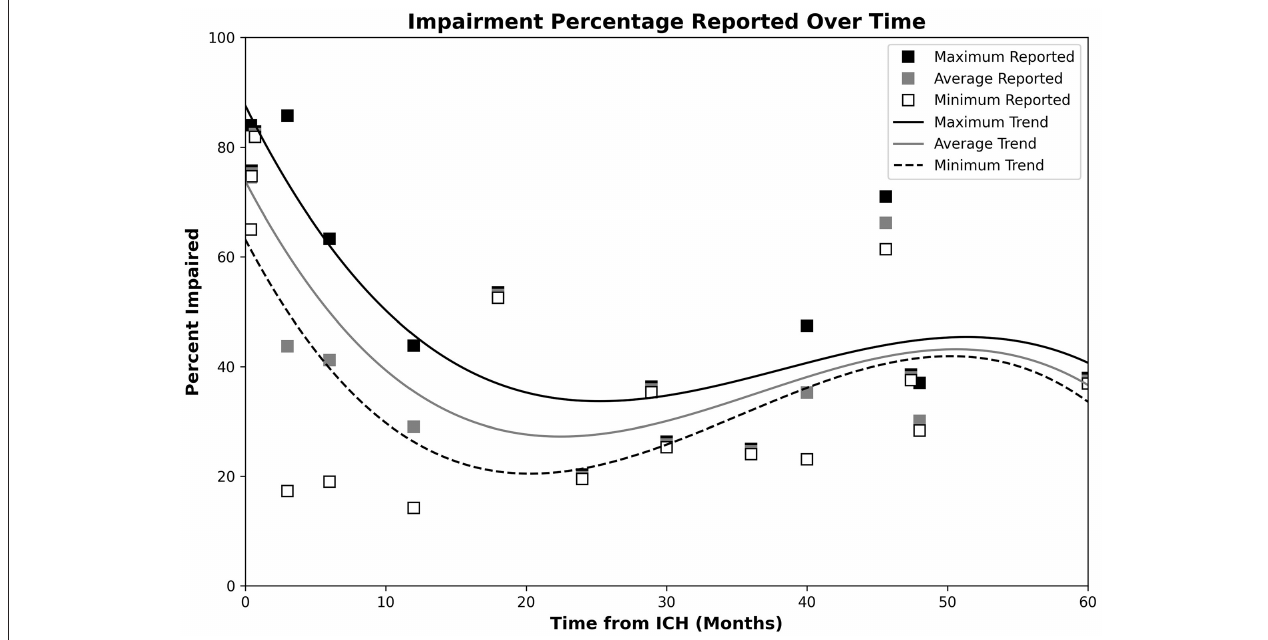
FIGURE 2 | Plot of post-ICH CI percentages, with trendlines reflecting the maximum, minimum, and average observed CI proportions. Data for the maximum, average, and minimum data points are, respectively, shown by the black, gray, and open white markers. Respective CI trends are shown using black, gray, and dashed lines. Impairment appeared highest during the acute phase, dropped to a minimum during the 20–24-month timespan, and steadily increased over the remaining observed timespan.